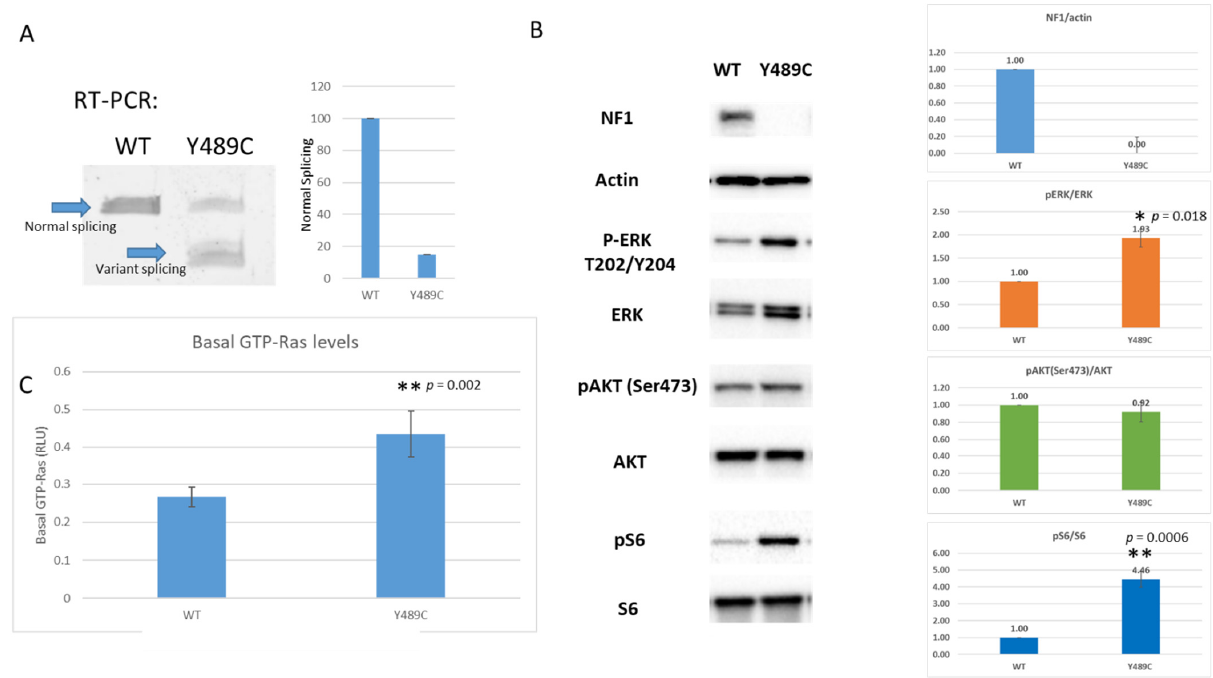
Figure 2. Characterization of c.1466A>G: p.Y489C variant specific iPS Cell Line model in comparison to WT parental PGP1 cells. ( A ) RT-PCR products on agarose gel, indicating leaky splicing of the variant. Quantitation of normal and abnormal splice variants indicates ~15% normal splicing, as indicated by the histogram (Error bars represent SD; N = 6 experiments). ( B ) Representative Western blots of WT PGP1 cells and Y489C variant containing PGP1 cells. Indicated Ras-pathway antibodies show altered Ras-signaling in the variant cells. Histograms to the right of the blots show quantification of N = 3 independent experiments. Error bars represent SD. Asterisks indicate statistical significance (* p < 0.05; ** p < 0.01). ( C ) Histogram evaluating GTP-Ras levels in WT and variant-containing cells.